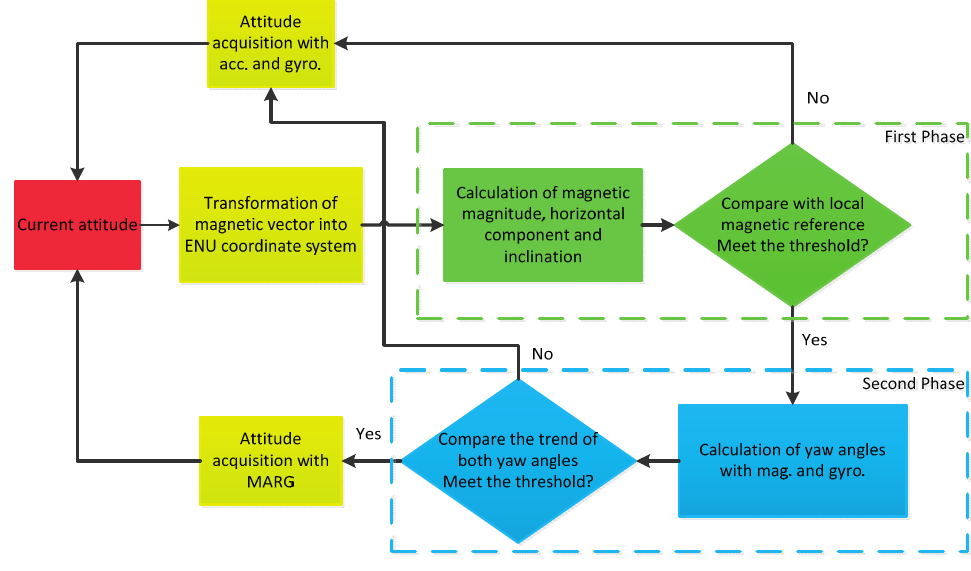
Figure 10. Flowchart of proposed two-phase filter scheme for avoiding magnetic